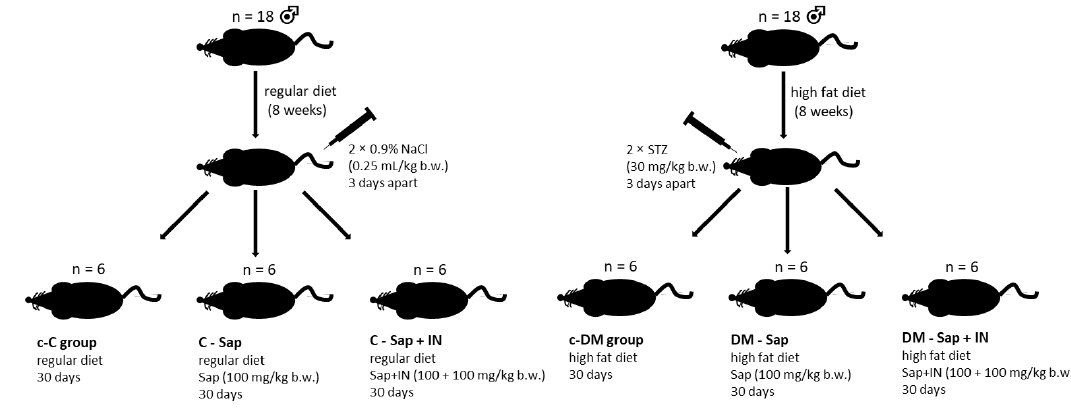
Figure 1. Schema of the experiment.